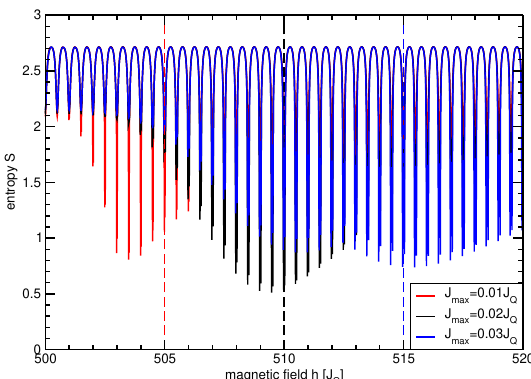
Figure 7: Residual entropy as function of the applied magnetic field for N = 3, z = 1 / 1000 and various values of J lines correspond to the estimate (50).